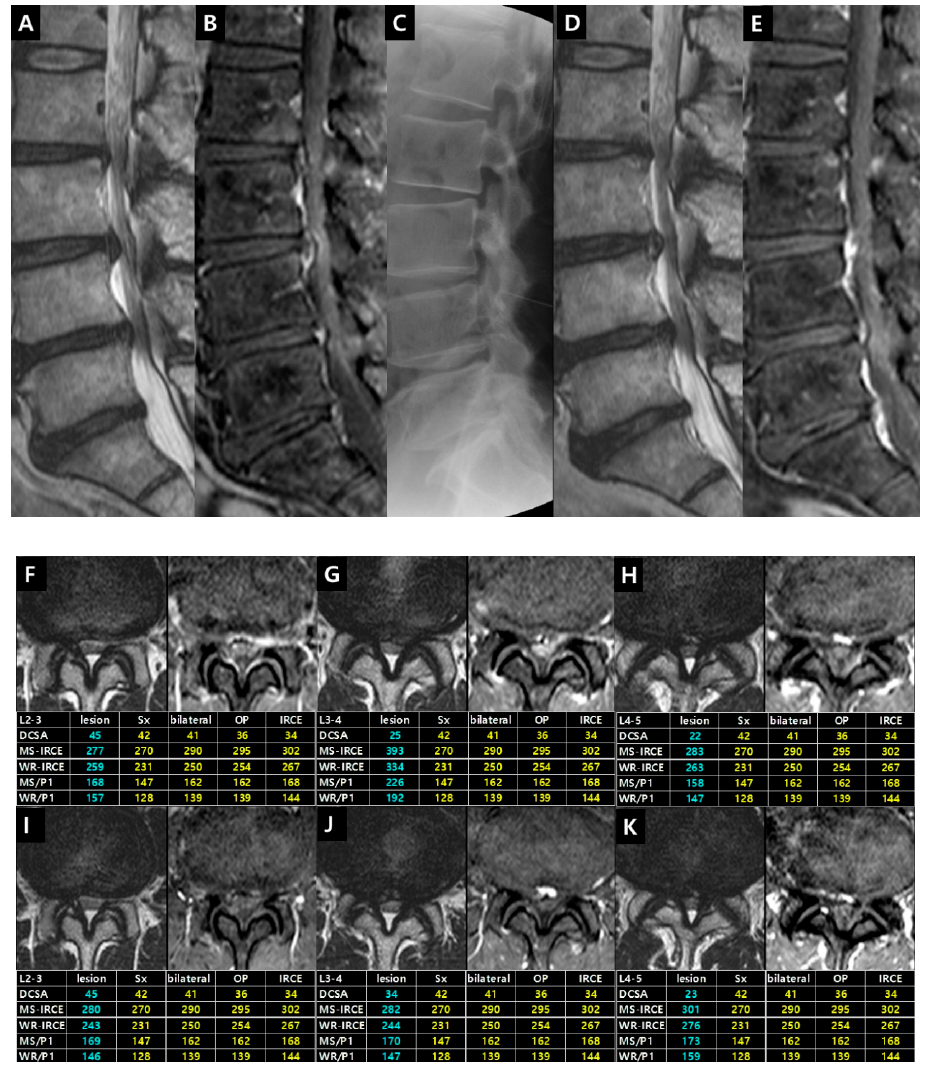
Figure 9. Illustrative Case 1. ( A ) T2-weighted and ( B ) fat-suppressed enhanced T1-weighted